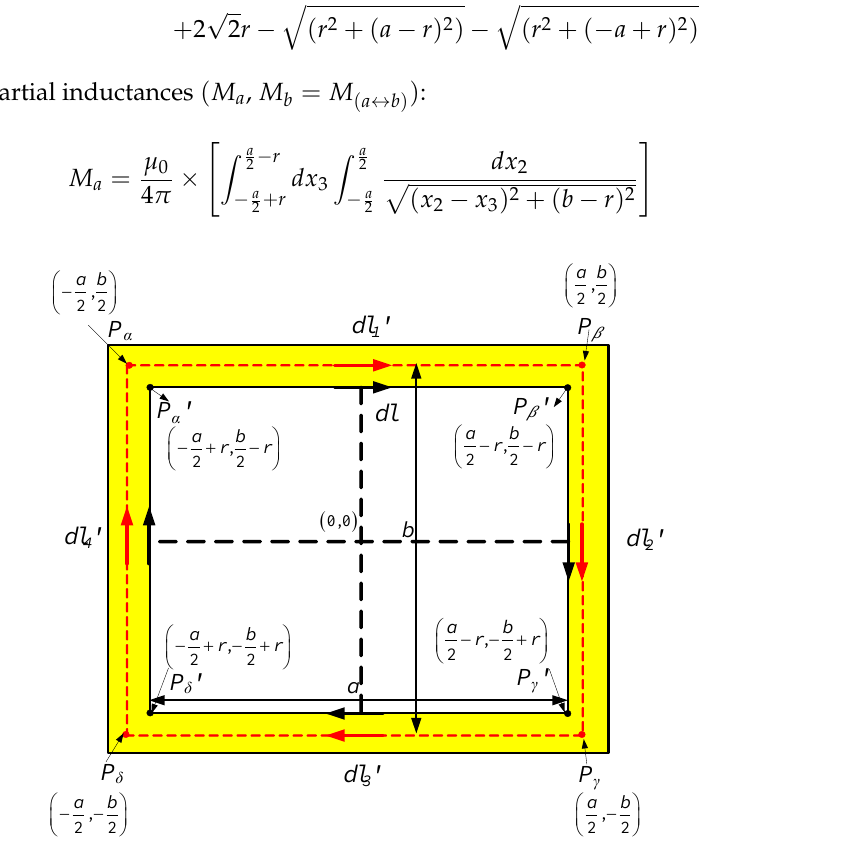
Figure 2. Definition of the contour of the elementary inner edge of a single turn rectangular coil dl and the various sections of the contour of the elementary line along the center of the wire ( dl For further evaluation, the contour of dl can be split at the top, right, bottom and left sections as ( dl 1 , dl 2 ,.. dl 4 )